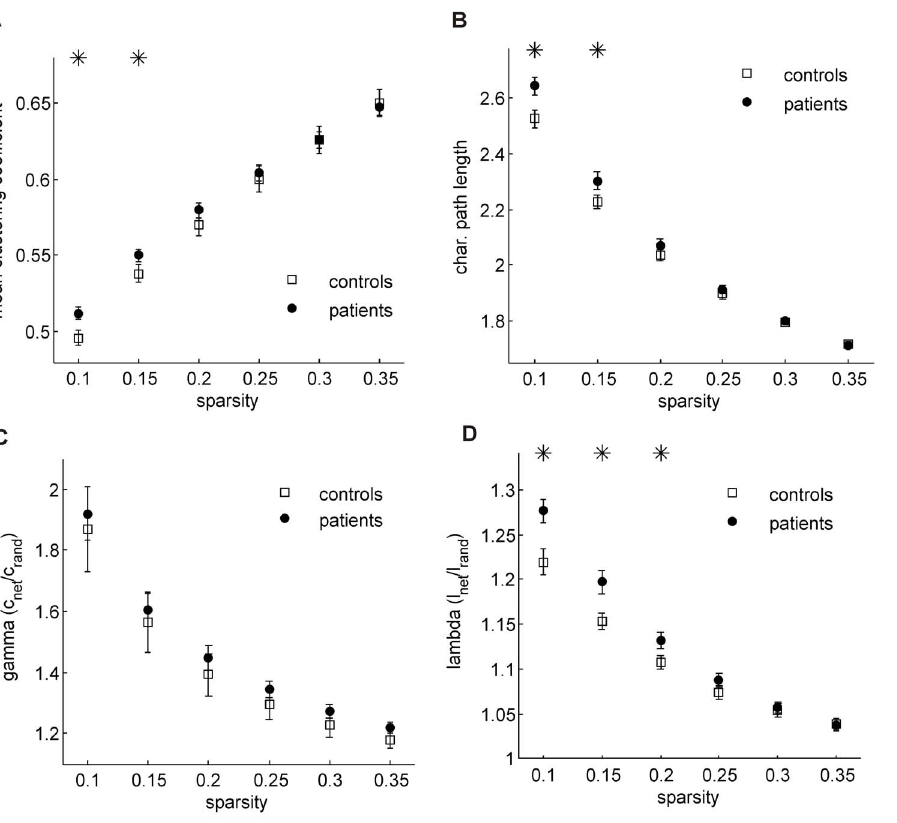
Figure 3. Global network properties for Parkinson’s disease patients (PD, full circles) and healthy controls (squares) as a function of the sparsity. A) mean clustering coefficient B) characteristic path length C) clustering coefficient normalized to a reference random network D) characteristic path length normalized to a reference random network. The asterisks indicate significant between-group differences (permutation test, a =0.05).